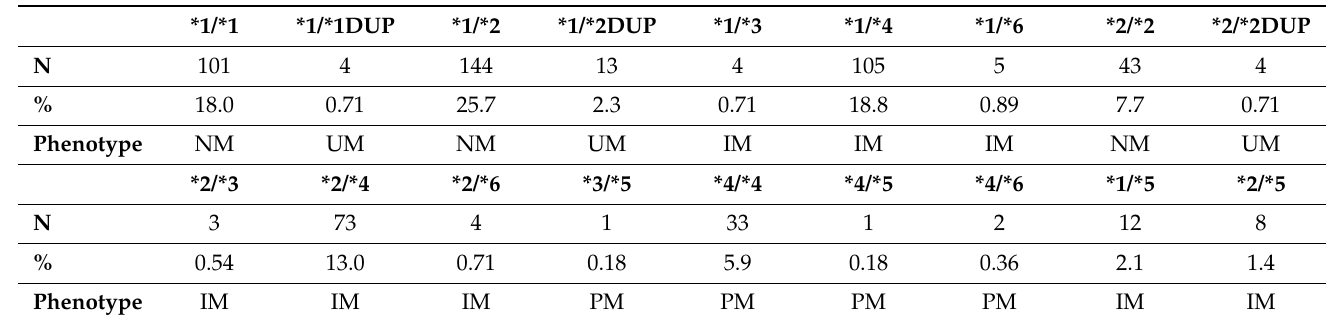
Table 5. Diplotype distribution for CYP2D6 .